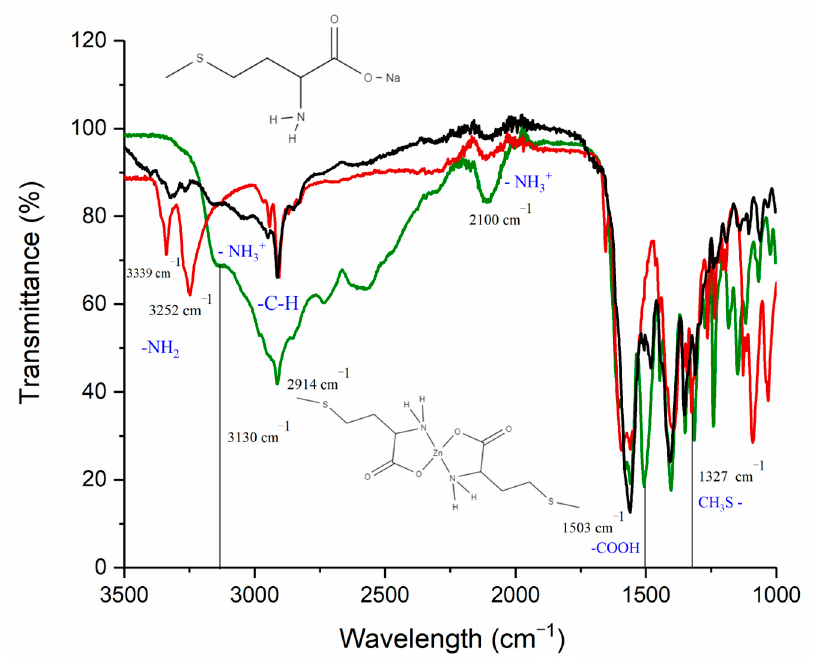
Figure 3. ATR-IR spectra of L-methionine (green), sodium methionine (black) and synthesized zinc methionine complex (red).